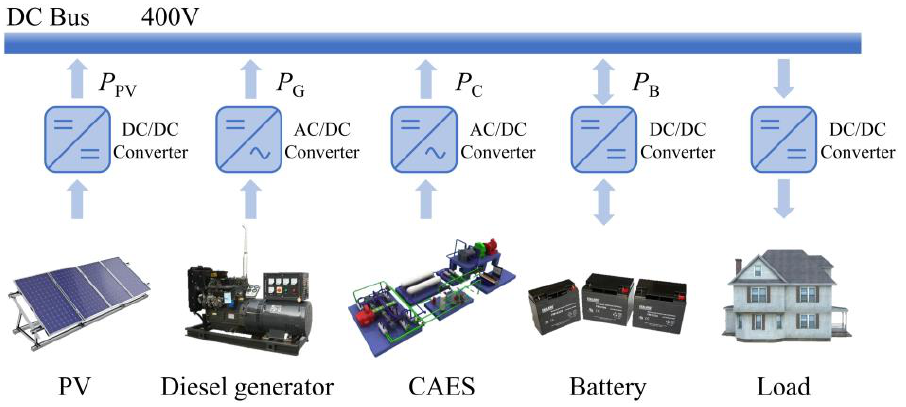
Figure 1. DC microgrid system structure.